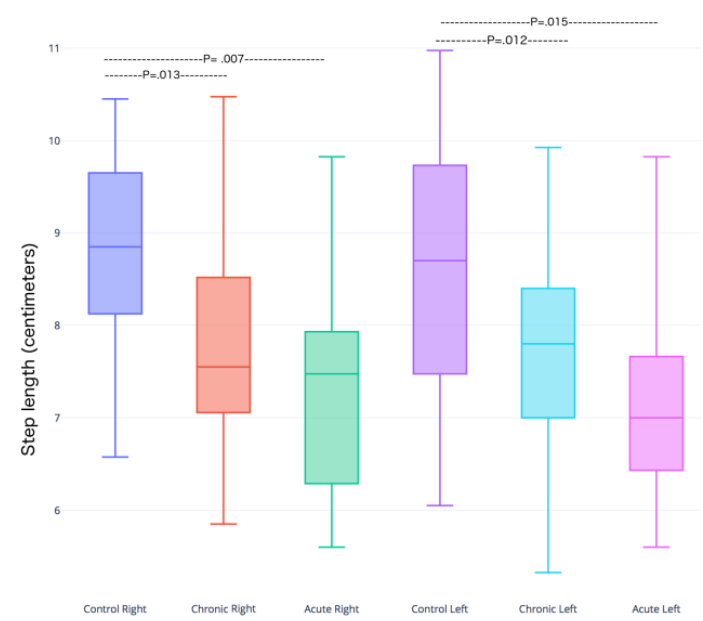
Figure 4. Box plots depicting the distribution of the step lengths in control, acute and chronic infected mice groups. The ordinate for each group for the right and left hindlimbs. The p-value of the Student’s t-test (α = 0.05) for each group is reported in the graph. There is greater change in step length in the right leg in the acute infection group vs the control; the difference in the left step length was significant, p < 0.015.